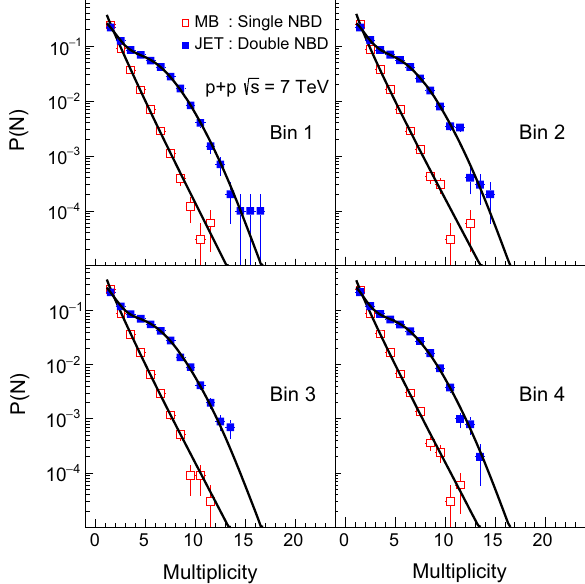
Fig. 2 Multiplicity distribution for minimum bias (red marker) and jet events (blue marker) in four particular η − φ bins in pp collisions at √ s = 7TeV from MC